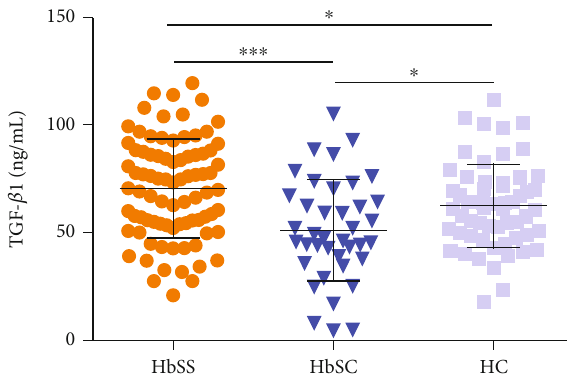
Figure 1: TGF- β 1 plasmatic levels in individuals with HbSS, HbSC, and healthy controls (HC). ∗ p < 0 : 05 ; ∗∗∗ p < 0 : 0001